Question: What form of chart is displayed?
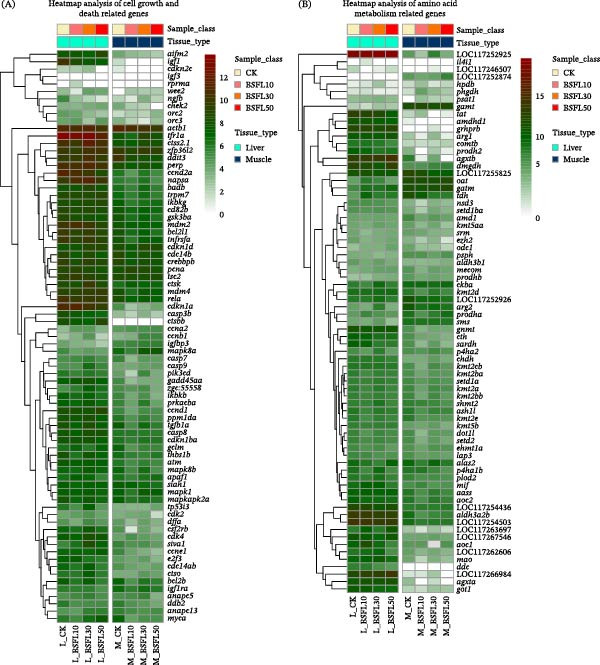
Answer: line